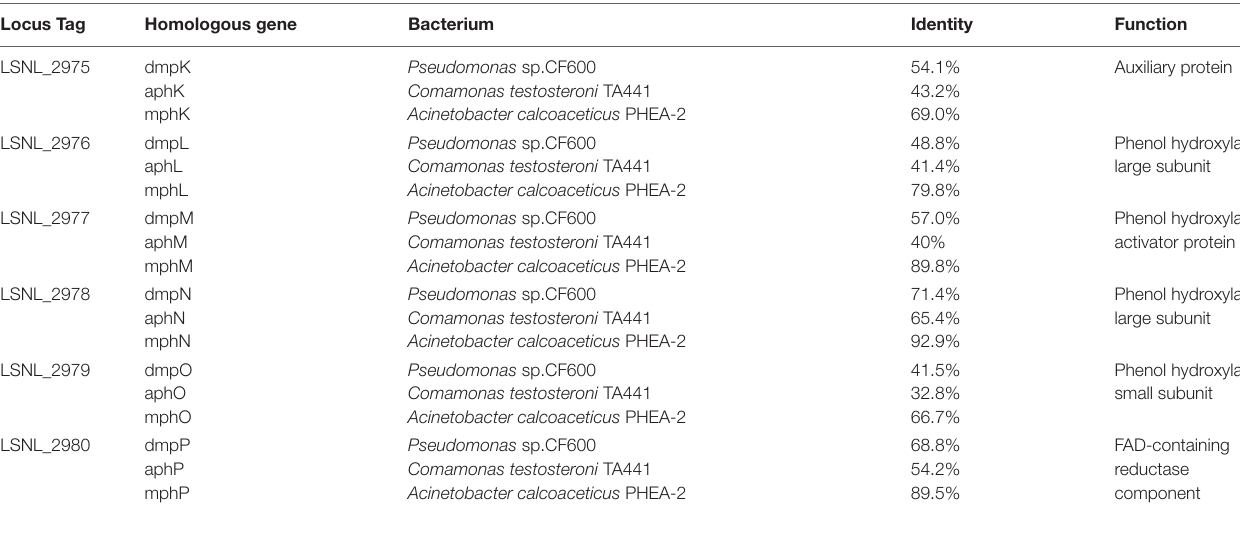
TABLE 2 | Homology comparison of A. lwoffii NL1 phenol hydroxylase-encoding genes. Locus